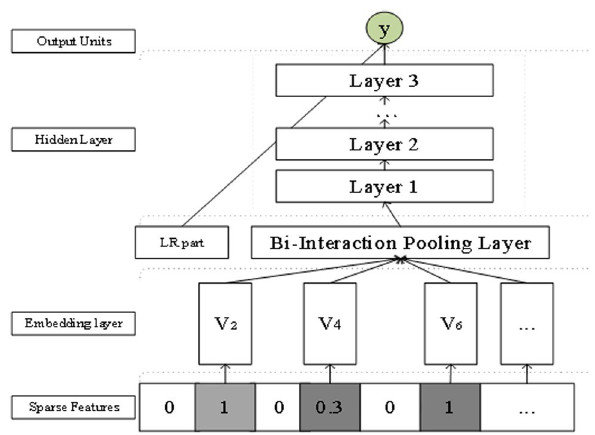
Fig. 3 Network topology of NFM Algorithm